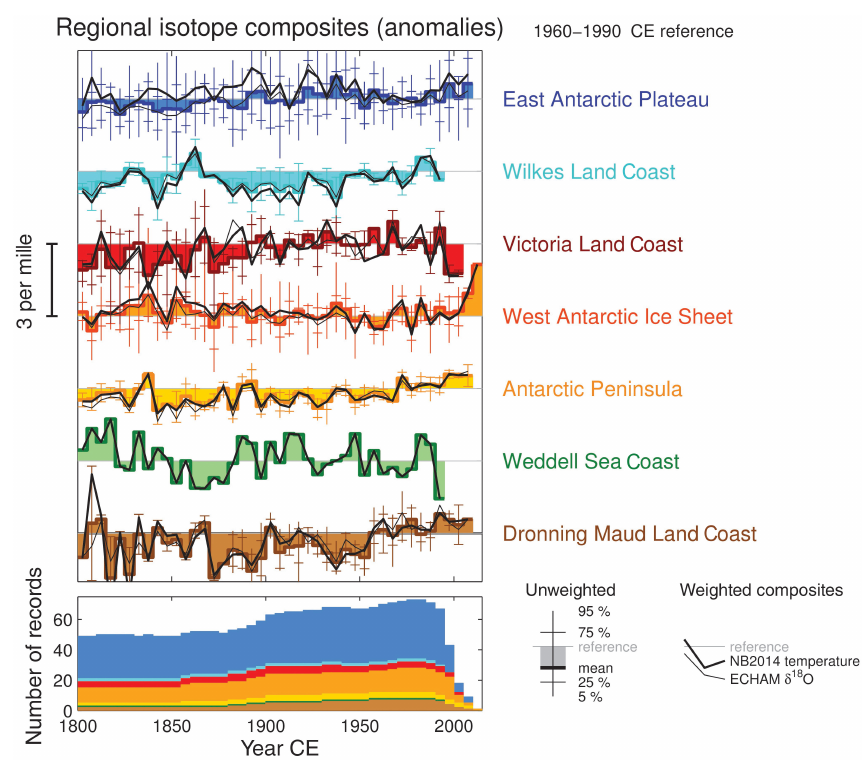
Figure 2. Regional δ 18 O composite reconstructions over the last 200 years using 5-year-binned anomaly data. Both unweighted composites and weighted composites (using both NB2014 temperature and ECHAM δ 18 O weighting methods) are shown. For each 5-year bin of the unweighted data, the mean δ 18 O anomaly across all records in the climatic region, as well as the distribution of δ 18 O anomalies within each bin, is calculated. All anomalies are expressed relative to the 1960–1990CE interval. The number of records that contribute to the reconstructions for each region are displayed in the lower